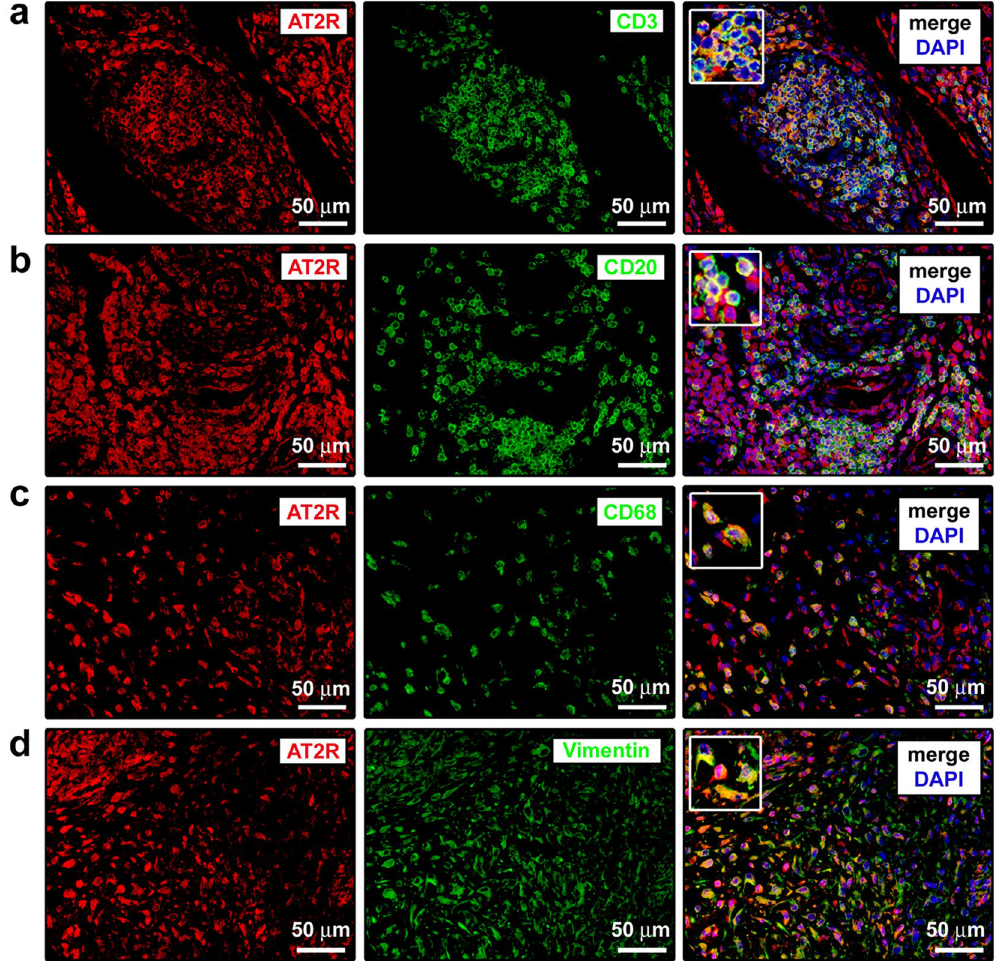
Figure 2. Expression of angiotensin II type 2 receptor (AT2R) in different cell types of rheumatoid arthritis (RA) synovium. ( a–d ) Representative microphotographs of synovial sections from patients with RA subjected to double immunofluorescence staining for AT2R (red) and the T cell marker CD3 (green) ( a ), the B cell marker CD20 (green) ( b ), the macrophage marker CD68 (green) ( c ) or the fibroblast marker vimentin (green) ( d ). Nuclei are counterstained with 4 ′ ,6-diamidino-2-phenylindole (DAPI; blue). Merge images are shown in the right panels. In RA synovium, AT2R is strongly expressed in CD3 + T cells ( a ) and CD20 + B cells ( b ) within ectopic lymphoid structures, CD68 + macrophages/type A synoviocytes ( c ) and vimentin + fibroblast-like synoviocytes/type B synoviocytes ( d ). Insets : higher magnifications of double-immunopositive synovial cells from the respective panels. Scale bars are indicated in each